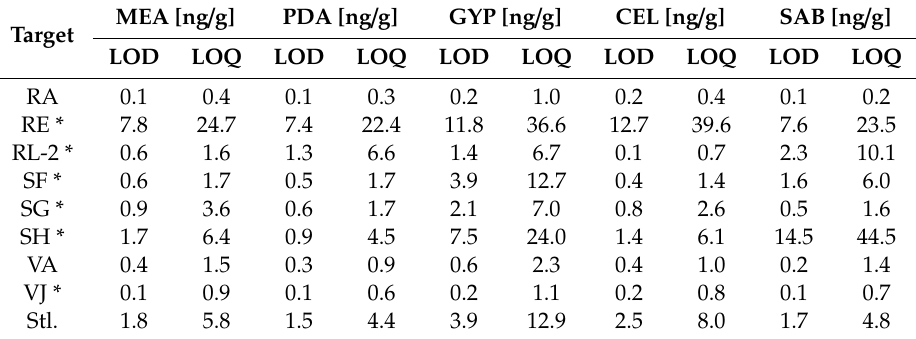
Table 2. Limit of detection and limit of